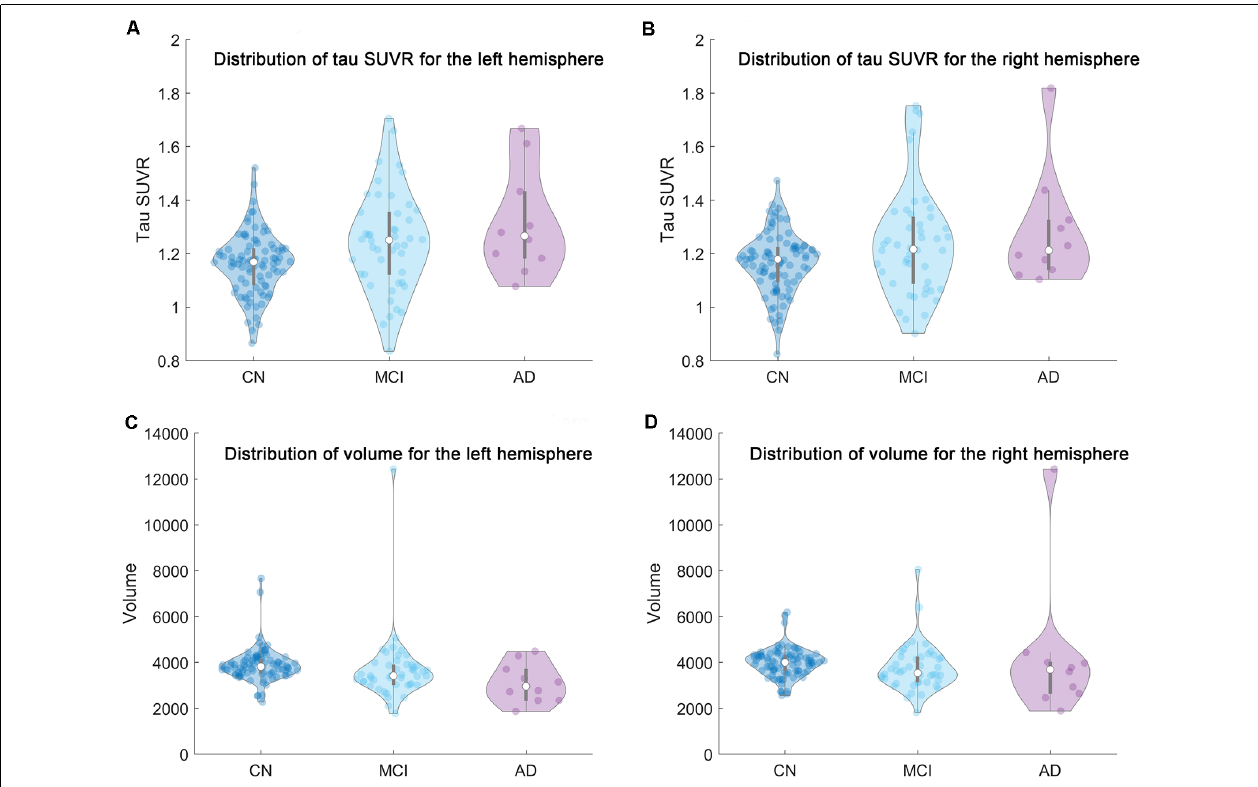
FIGURE 2 | The distribution of the mean tau SUVR and total volume of the whole region comprised of the six subfields in the current research for each group (CN/MCI/AD) were shown based on violin plot. From left to right and top to bottom are the distribution of (A) the mean tau SUVR for the left hemisphere, (B) the mean tau SUVR for the right hemisphere, (C) the total volume for the left hemisphere, and (D) the total volume for the right hemisphere,